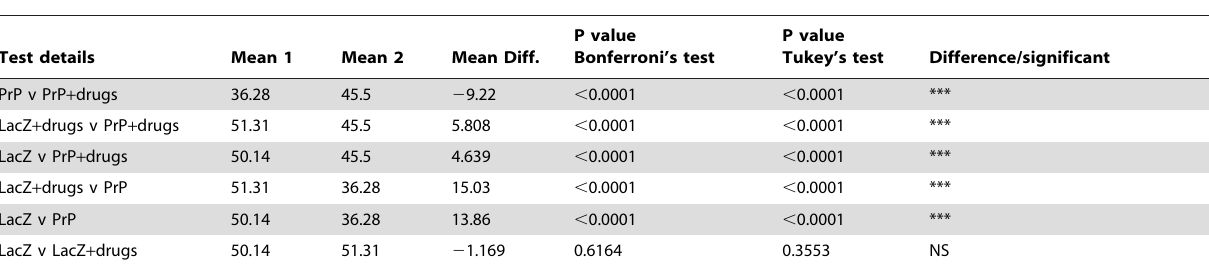
Table 5. Statistical comparisons (ANOVA) for climbing